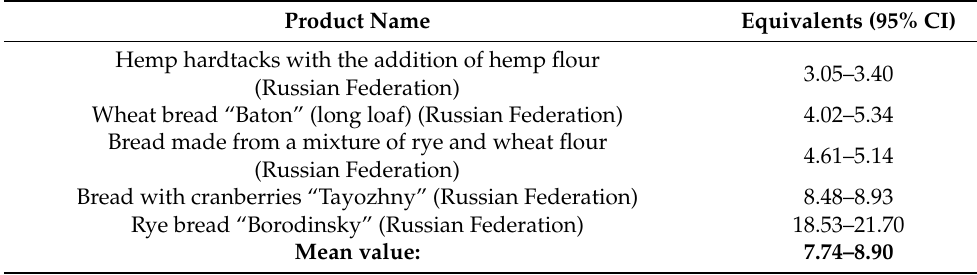
Table 1. The ARP for bakery products with a 95% confidence interval.